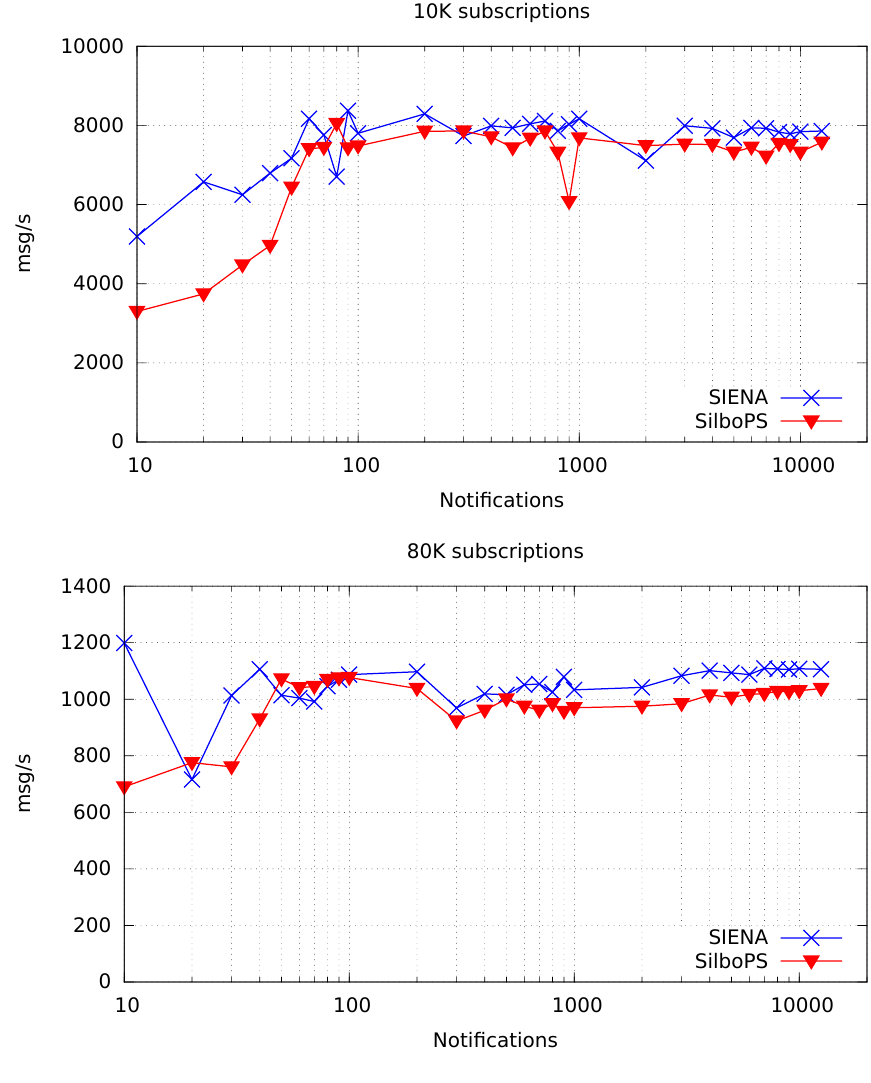
Figure 11. Notification throughput with 10,000 and 80,000 subscriptions in a single broker.